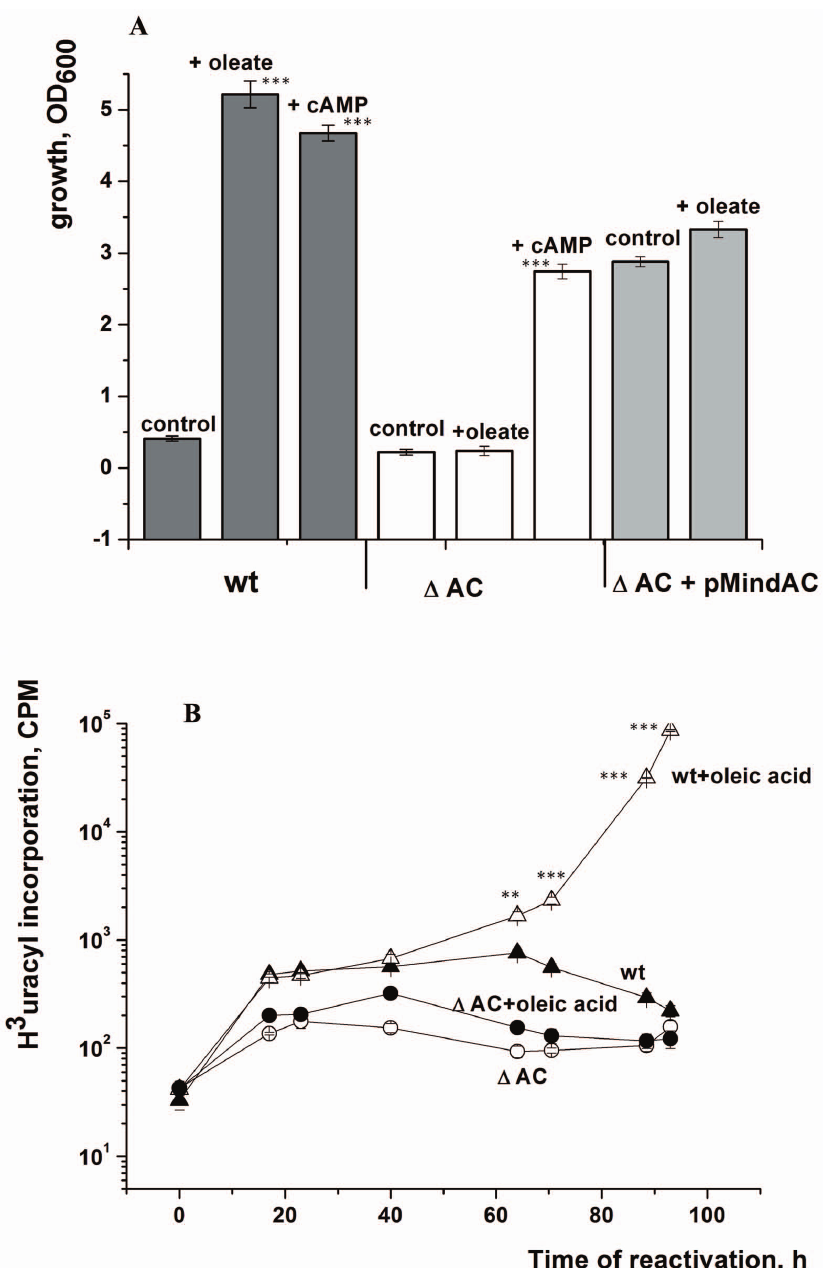
strain, D AC(pMindAc), and after 11 d for the D AC knock-out strain. Oleic acid and cAMP were added at concentrations of 3.5 m M and 3 mM, respectively. In part B, samples were taken at intervals over the first four days from cultures of the wild type and the mutant, both with and without oleic acid, for the estimation of cellular metabolic activity (uracil incorporation). Asterisks in Fig. 6A indicate that the results are significantly different from the control for each strain by Student’s t-test. Asterisks in Fig. 6B indicate significant difference between wt cells and wt + oleic acid by Student’s t-test.